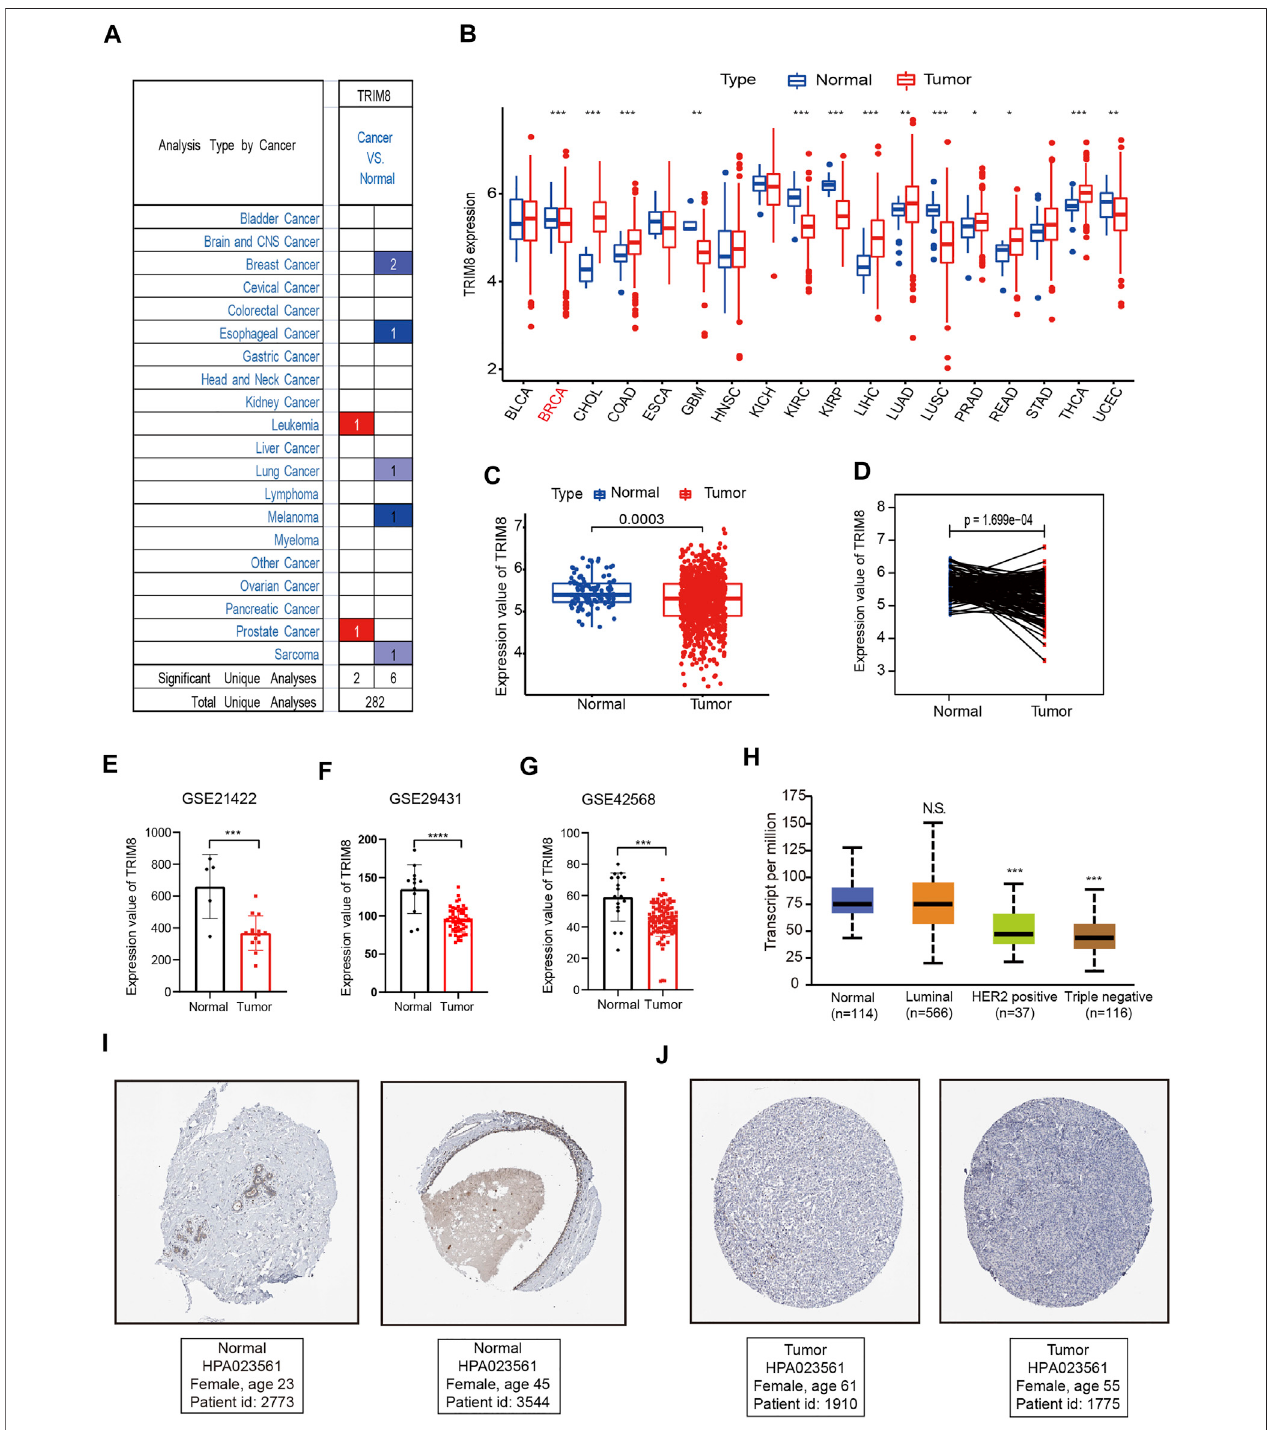
FIGURE2| TRIM8expressionlevelsindifferenttypesofhumancancers (A) TheexpressionlevelofTRIM8indifferentcancertissuescomparedwithnormaltissues from the Oncomine database. Numbers in red and blue represented dataset numbers in which levels of TRIM8 were statistically increased or decreased. (B) TRIM8 expressionlevelsindifferentcancertissuescomparedwithnormaltissuesfrombreastcancerandnormaltissuesfromTCGAdatabase.Reddotsrepresentedtumorand blue represented normal (C) TRIM8 expression levels of normal and breast cancer tissue in TCGA. (D) Relative expressions of TRIM8 mRNA in 224 pairs of breast cancer tissues and adjacent noncancerous tissues from TCGA database (E) TRIM8 expression levels of normal and breast cancer tissues in GSE21422. (F) TRIM8 expressionlevelsofnormalandbreastcancertissuesinGSE29431 (G) TRIM8expressionlevelsofnormalandbreastcancertissuesinGSE42568. (H) Boxplotsshowed TRIM8 expression levels in different molecular subtypes patients with breast cancer (I – J) The images obtained from The Human Protein Atlas database. Representative IHC images showed TRIM8 expression in normal tissues (I) and breast cancer tissues (J) .